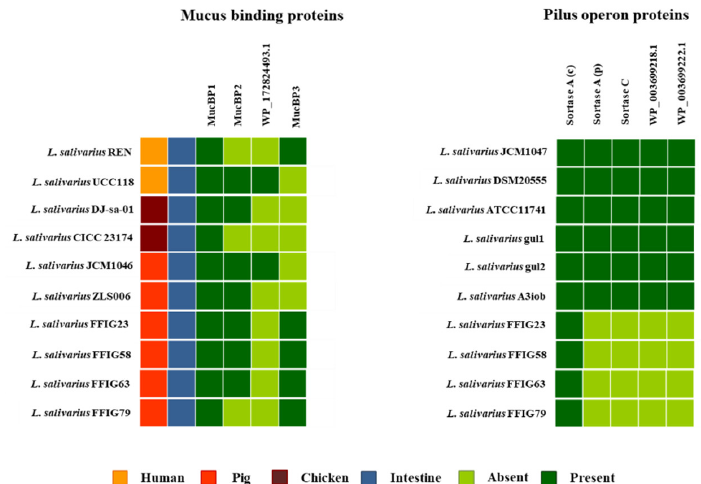
Figure 11. Genomic comparison of the mucus binding proteins and the pilus operon from Ligilactobacillus salivarius strains isolated from the intestinal mucosa of wakame-fed pigs with L. salivarius strains with available public genomes. Mucus binding proteins were compared with probiotic L. salivarius strains isolated from the intestinal tract of humans, pigs, and chickens. Gene of proteins associated with pilus operon were compared to the six L. salivarius strains that were predicted to harbor a pilus operon by genomic analysis.